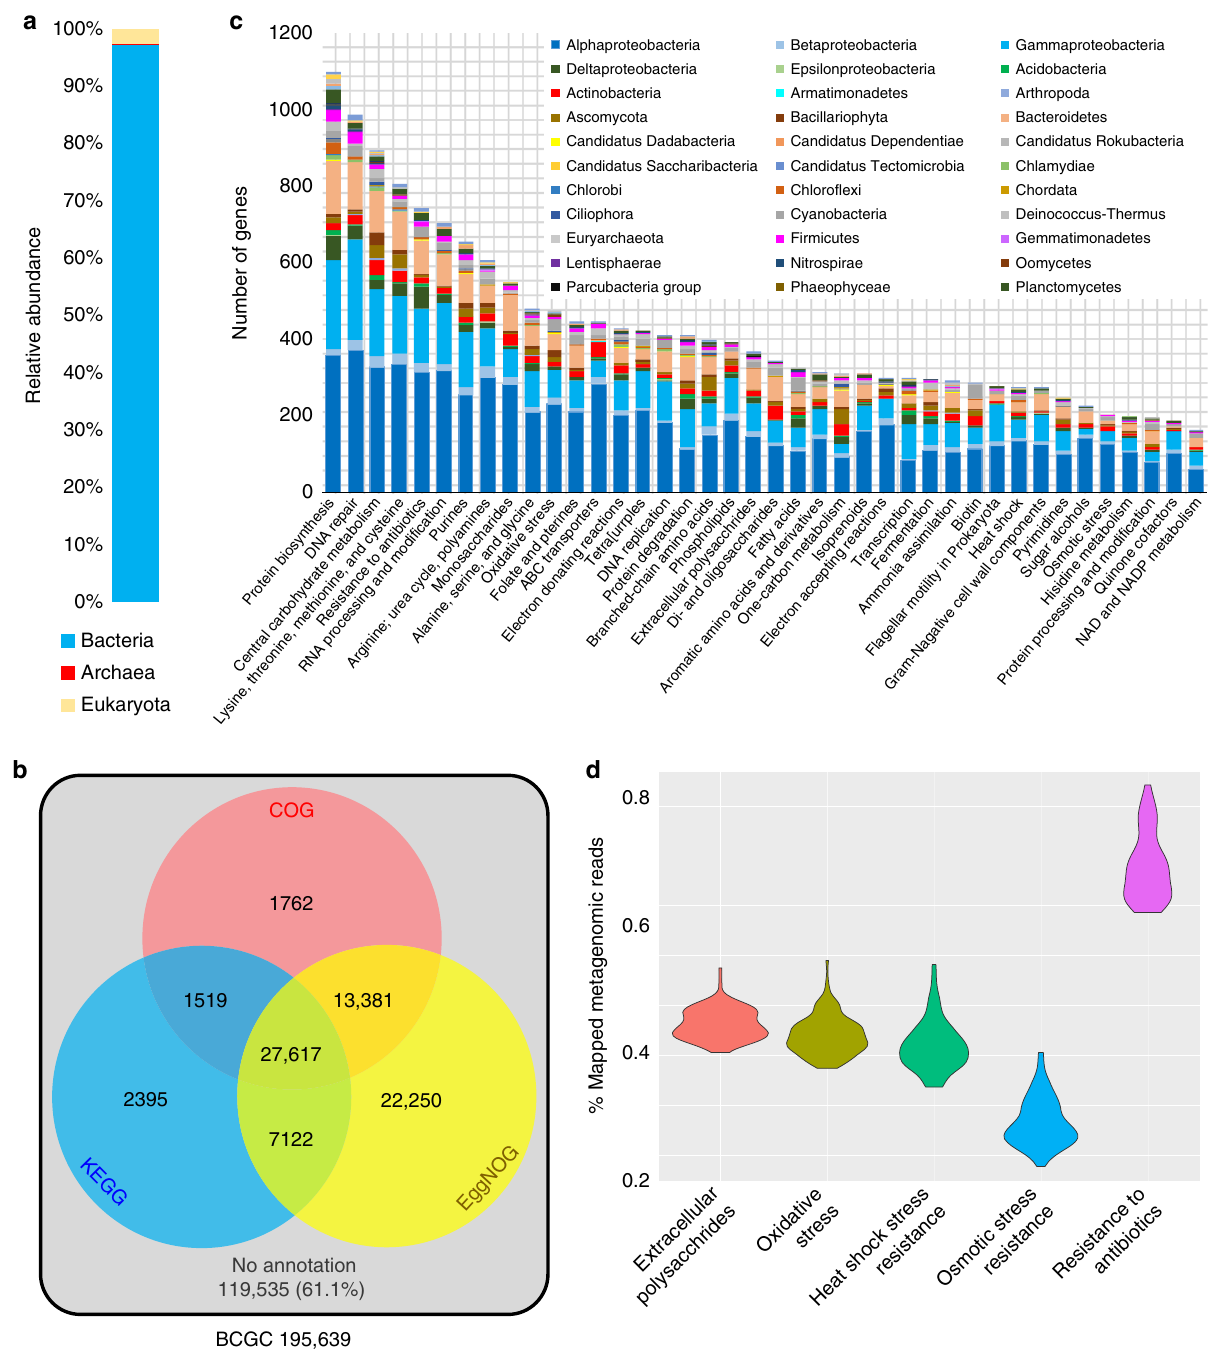
Fig. 4 Functional structuring of the bio fi lm core gene catalog (BCGC). a Taxonomic breakdown of BCGC genes, 97.3% of which belong to bacteria. b BCGC is a nonredundant database comprising genes that are present in more than 99 bio fi lms but which were not detected in any of the seawater samples. Venn diagram showing the total number of genes in the BCGC and the number of genes annotated by three databases. 61.1% of the BCGC genes could not be annotated. c Distribution of the annotated BCGC genes in different SEED categories and their taxonomic af fi liation. The 40 most enriched SEED categories and their phylum-level af fi liations are shown. d Reads mapping to BCGC genes in SEED categories related to extracellular polysaccharide biosynthesis, stress and antibiotic resistance, showing the abundance distribution of these functions across the 101 bio fi